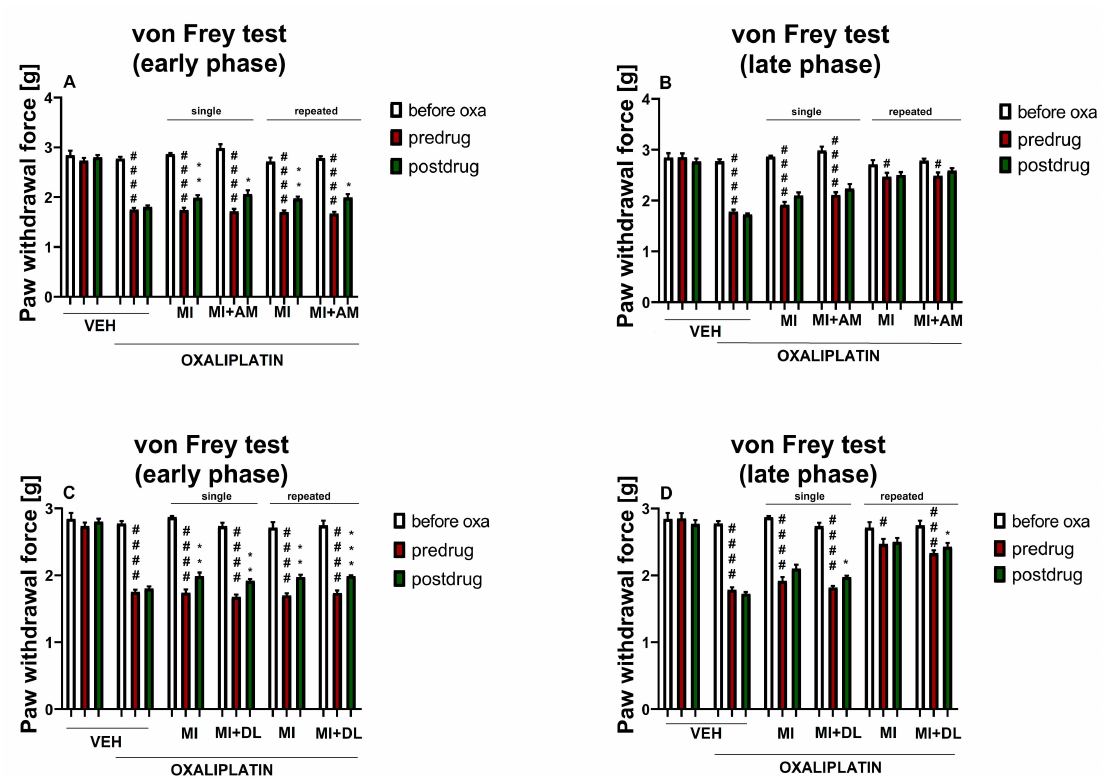
Figure 3. Effect of single-dose and repeated-dose minocycline combined with ambroxol or duloxetine on pain threshold in oxaliplatin-treated mice. Effect of minocycline (50 mg/kg, i.p.) combined with ambroxol (90 mg/kg, i.p.) measured in the von Frey test on the day of oxaliplatin administration ( A ) and 7 days later ( B ). Effect of minocycline (50 mg/kg, i.p.) combined with duloxetine (10 mg/kg, i.p.) on tactile allodynia measured in the von Frey test on the day of oxaliplatin administration ( C ) and 7 days later ( D ). The results for minocycline used in combination and minocycline used alone (50 mg/kg) are shown as the mean paw withdrawal threshold ± SEM for n = 9–10. Statistical analysis: repeated measures ANOVA followed by Tukey’s post-hoc comparison. Significance: # p < 0.05, ### p < 0.001, #### p < 0.0001 vs. before oxaliplatin; * p < 0.05, ** p < 0.01, *** p < 0.001 vs. pre-drug paw withdrawal threshold in the individual group. Abbreviations: oxa—oxaliplatin, MI—minocycline, AM—ambroxol, DL—duloxetine. In the figure titles ‘early phase’ ( A , C ) and ‘late phase’ ( B , D ) mean two time points at which the measurements were taken (day of oxaliplatin administration and day 7 after a single-dose oxaliplatin administration, respectively). Numerical values of the paw withdrawal thresholds ± SEM presented in this figure are shown in the Supplementary Materials (Table